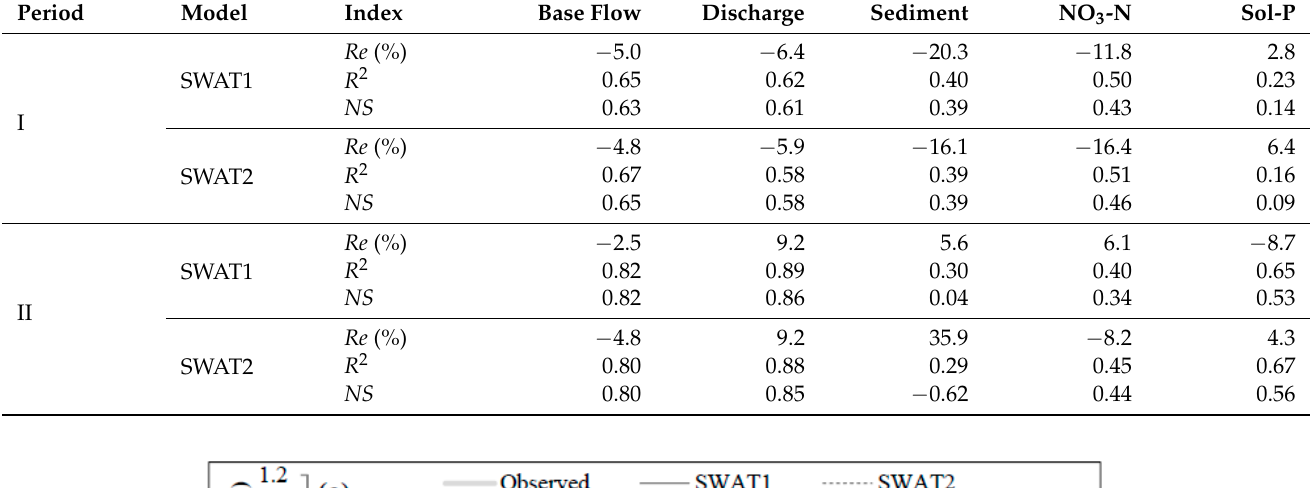
Table 5. Model assessments for SWAT1 and SWAT2 during two periods.